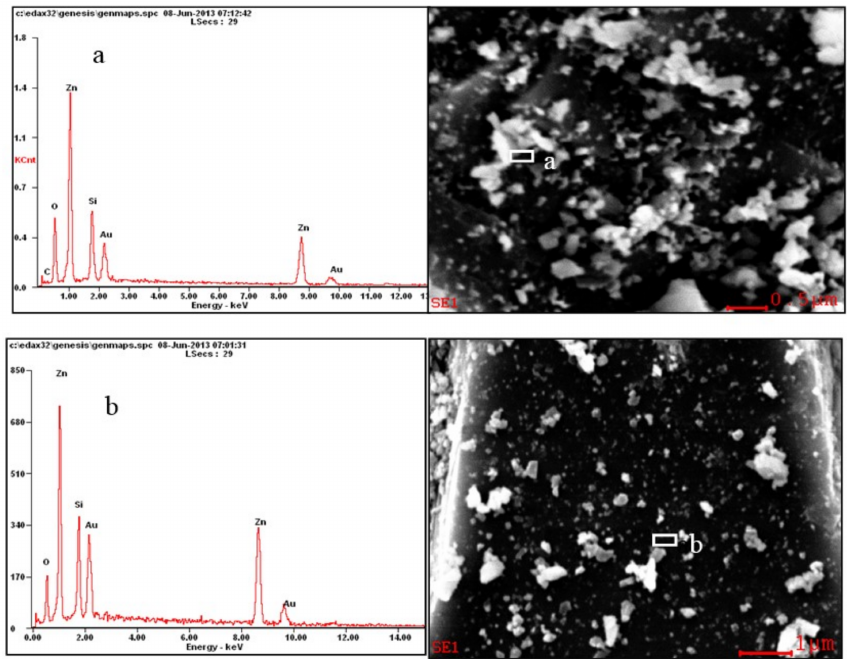
Figure 6. Energy dispersive spectroscopy of hemimorphite before ( a ) and after ( b ) reaction with Na 2 CO 3